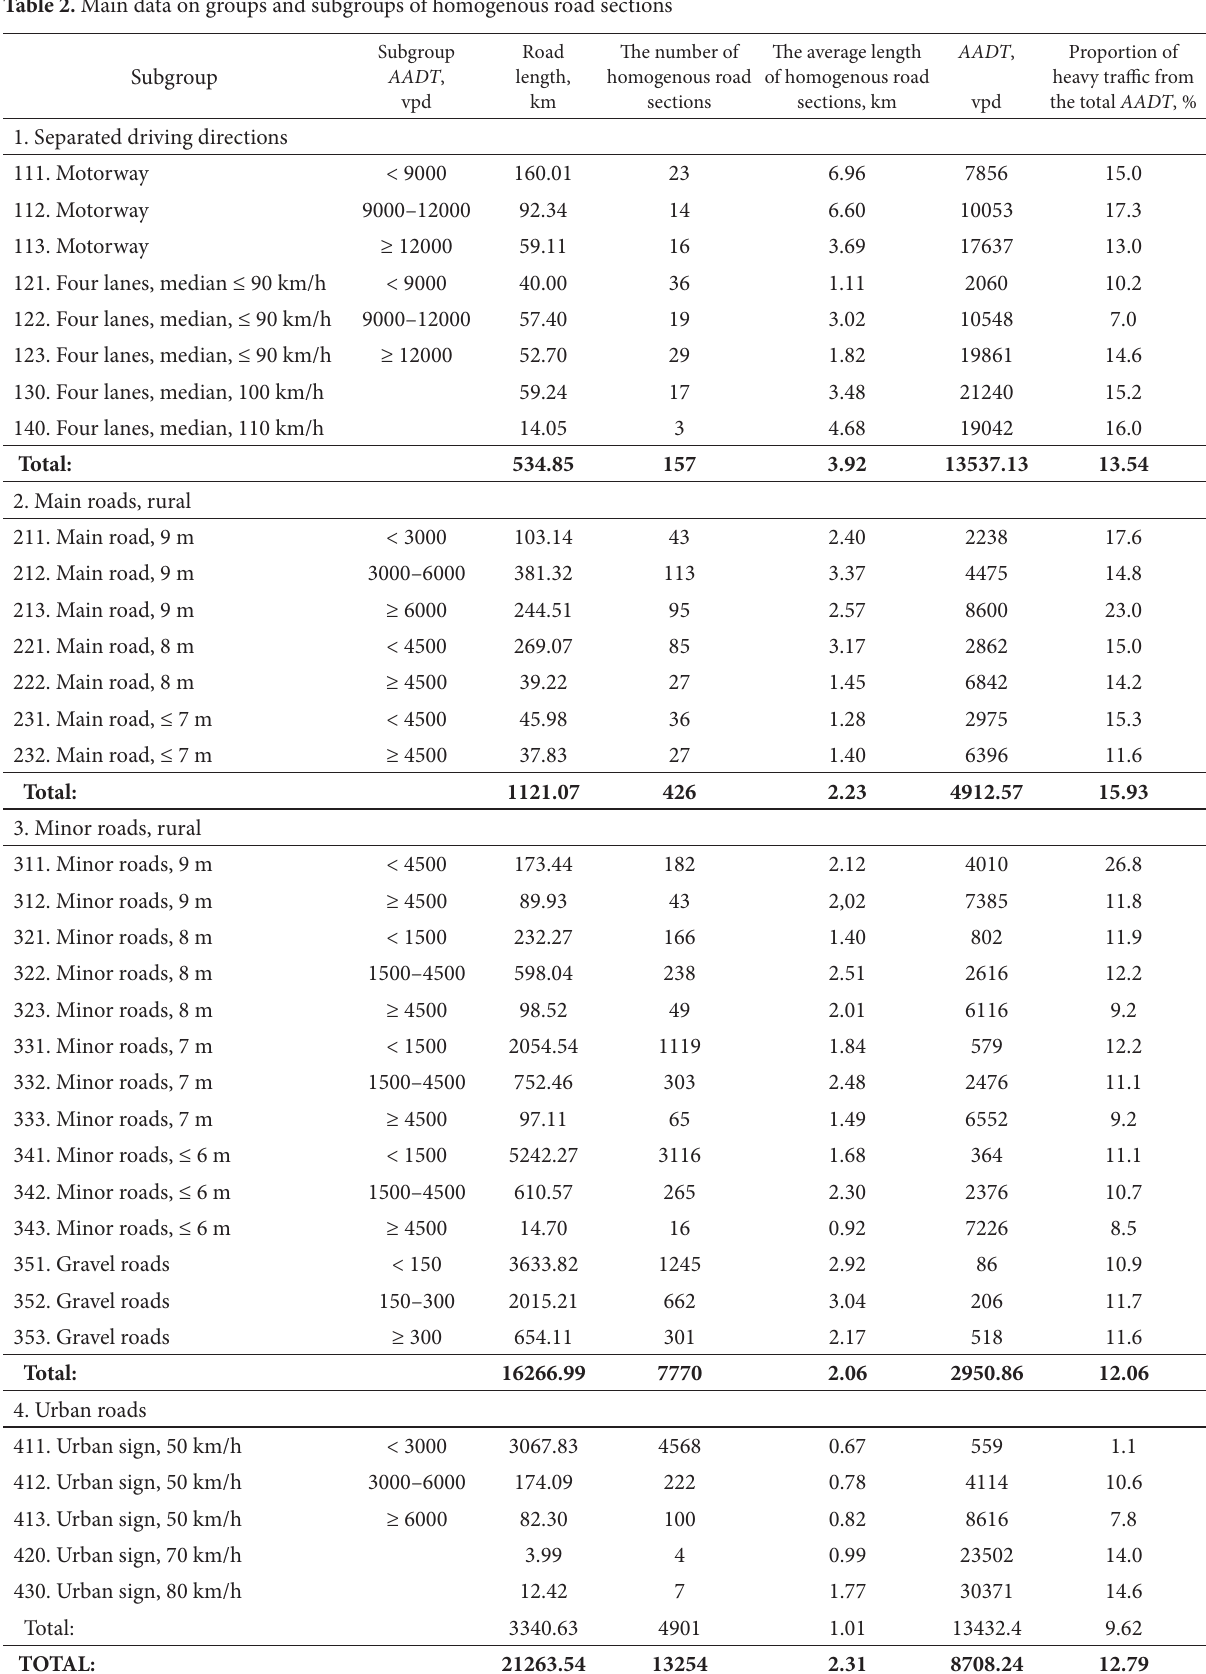
Table 2. Main data on groups and subgroups of homogenous road sections